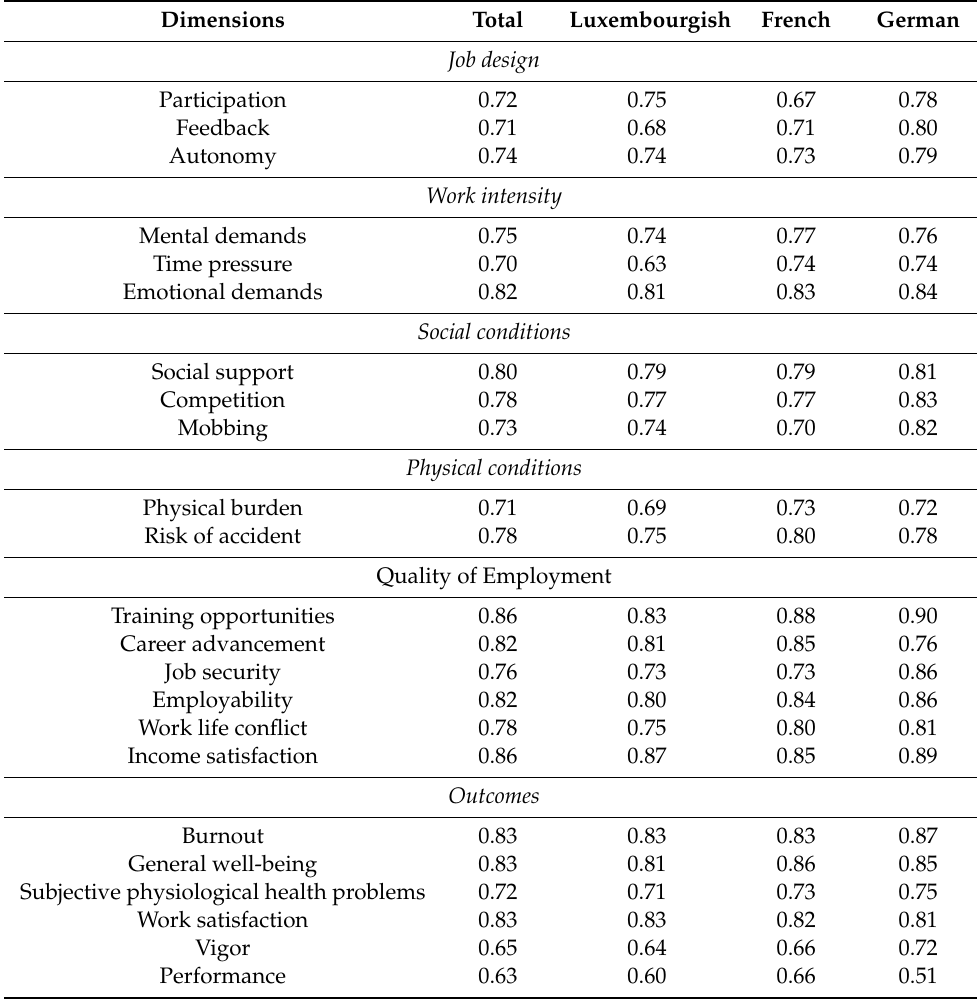
Table 5. Internal consistencies across the language